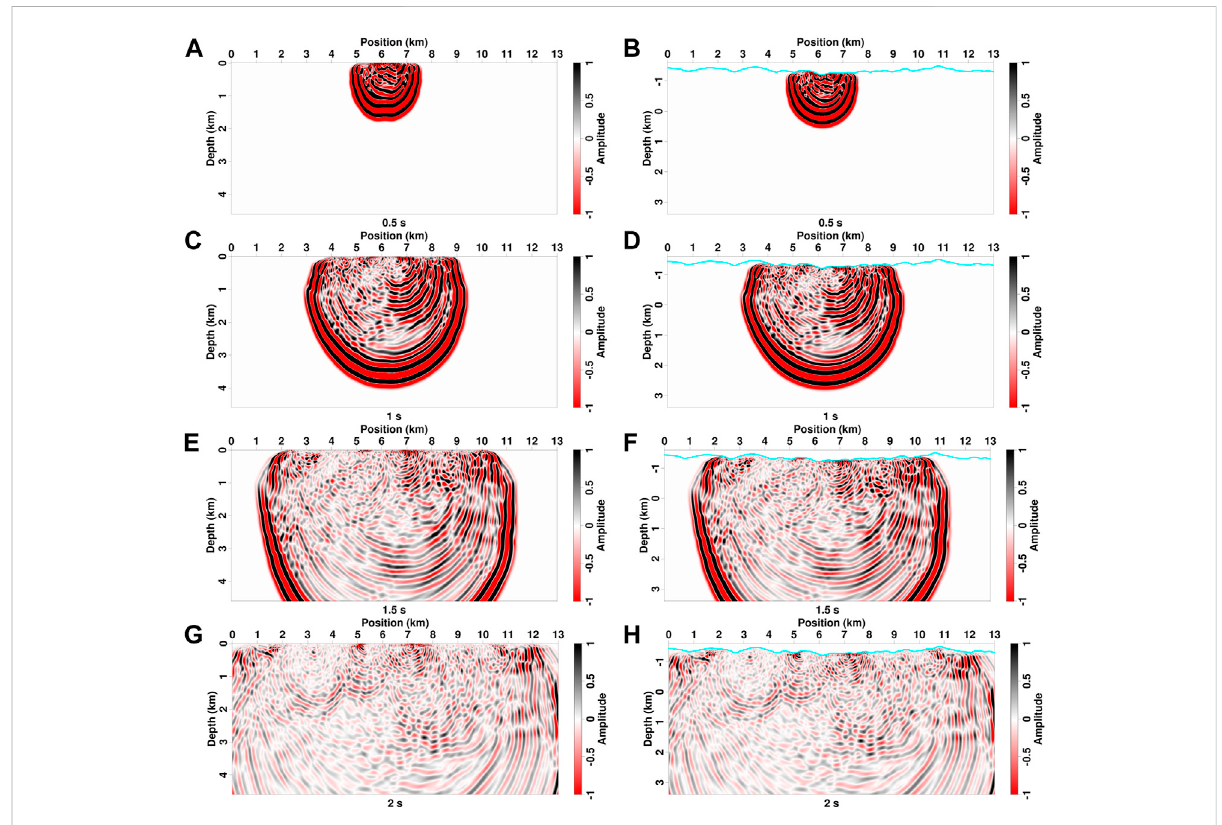
FIGURE 12 (A – H) Viscoacousticwave fi eldsofdifferentpropagationtimesforthe2DLoessPlateaumodelsimulatedwithatopfree-surfaceboundaryinthe computational domain (left column) and physical domain (right column). The cyan lines in panels (B,D,F, and H) denote the topography.